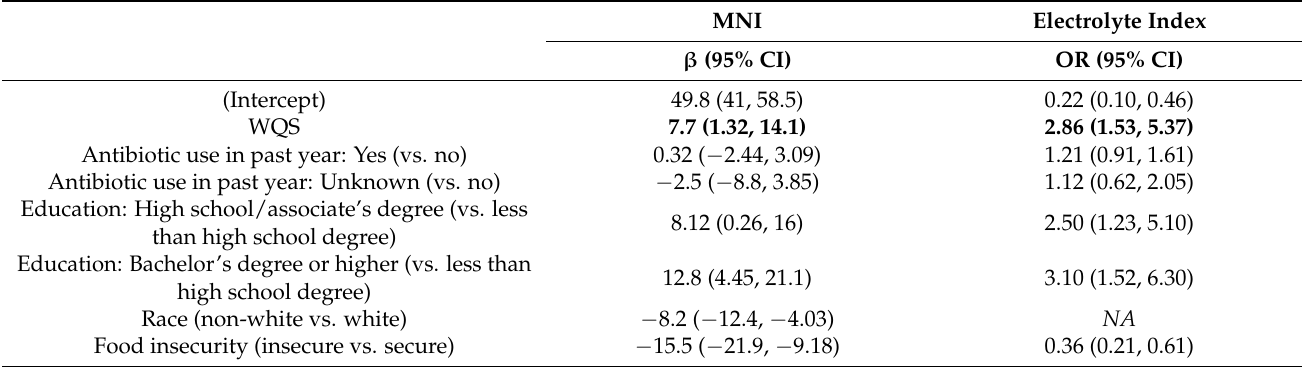
Table 3. Results from the stratified repeated holdout WQSRS regression, with positively constrained betas, for the Gaussian and logit models with non-zero OTUs deciled in generalized linear models and adjusted for covariates, stratified by food security status (food secure versus insecure). MNI n = 623, Electrolyte index n = 624. MNI Electrolyte Index β (95% CI) OR (95% CI)